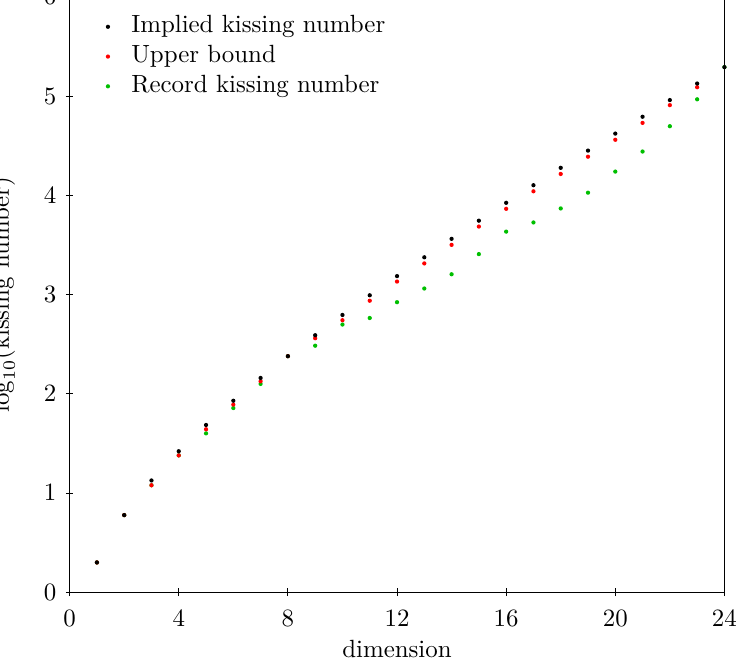
Figure 14 . The implied kissing number from the linear programming bound, compared with the best upper bound known for the actual kissing number [71] and the current record